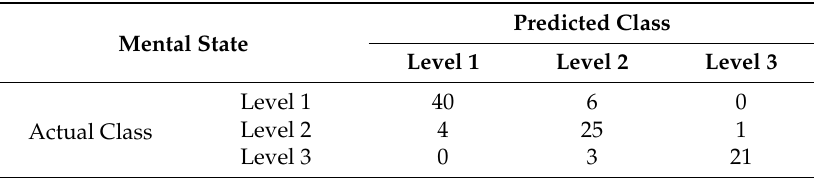
Table 4. The confusion matrix of mental state